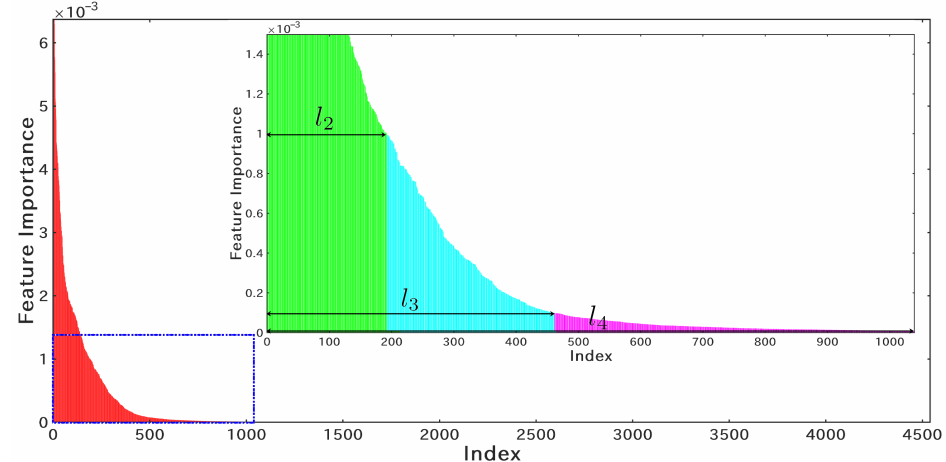
Figure 5. The feature importance distribution of the RF classifier obtained from the Nextstrain training dataset. The index is the result of sorting the sites in descending order of importance. l 2 , l 3 , and l 4 are obtained by setting the threshold of the feature importance to 10 − 3 , 10 − 4 , and 10 − 5